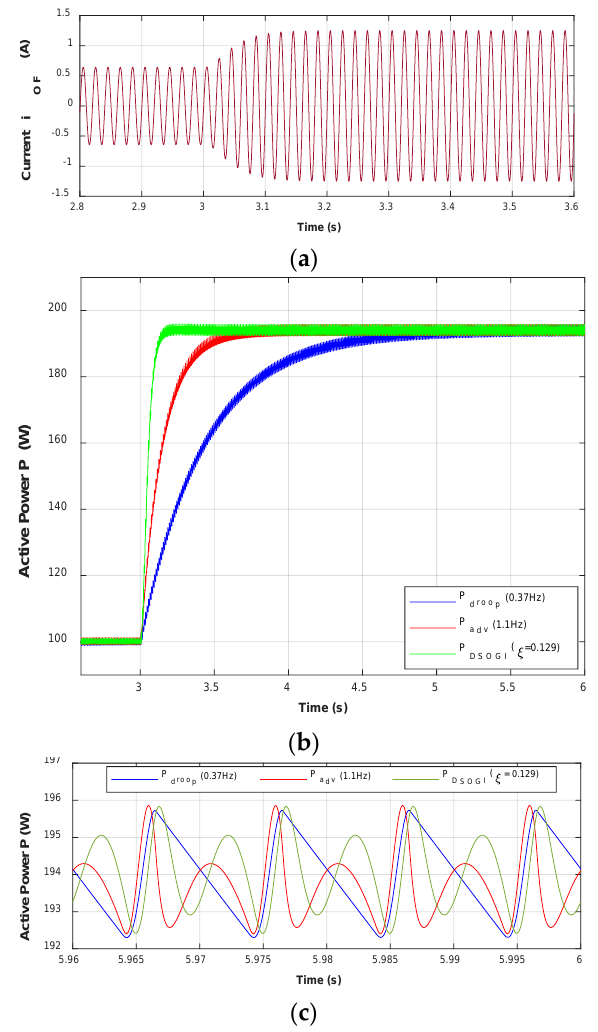
Figure 14. Simulation of i OF and P av transient responses for a nonlinear DBR load current perturbation from a peak of 2.48 A to 4.15 A at 3 s: ( a ) detail of the i OF perturbation, ( b ) P DSOGI , P adv and P droop , ( c ) detail of P DSOGI , P adv and P droop